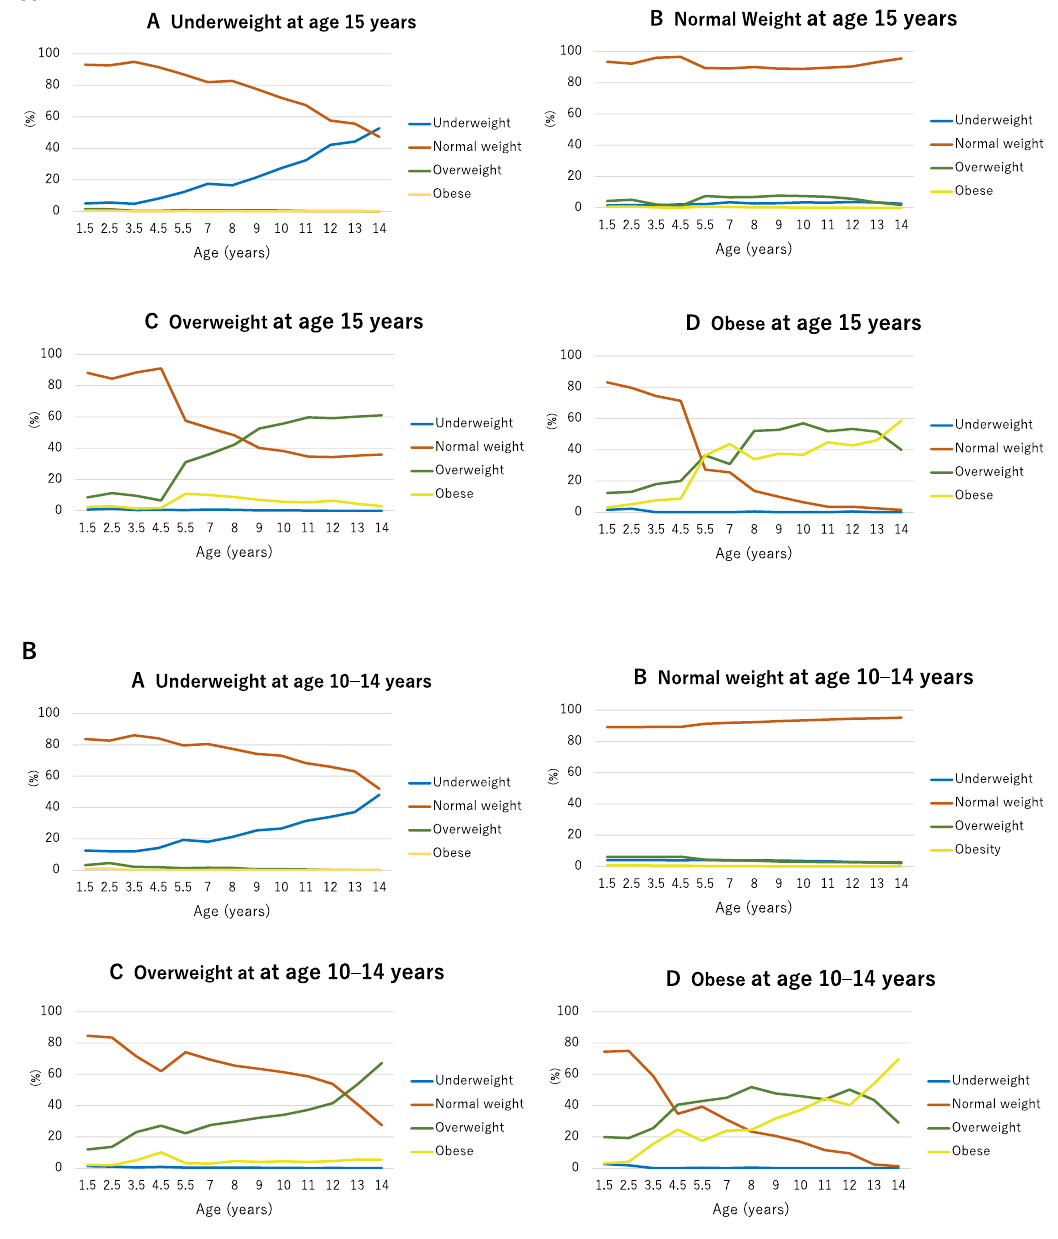
at age 15 years: underweight ( A ), normal weight ( B ), overweight ( C ) and obese ( D ). (Panel B ). Prospective tracking of annual BMI status [underweight ( A ), normal weight ( B ), overweight ( C ), and obese (D )] from childhood (age 18 months to 14 years) to adolescence (age 15 years). BMI status categorization was based on the WHO definitions (under 5 years: overweight ≥ 2 SD, obese ≥ 3 SD; over 5 years: overweight ≥ 1 SD, obese ≥ 2